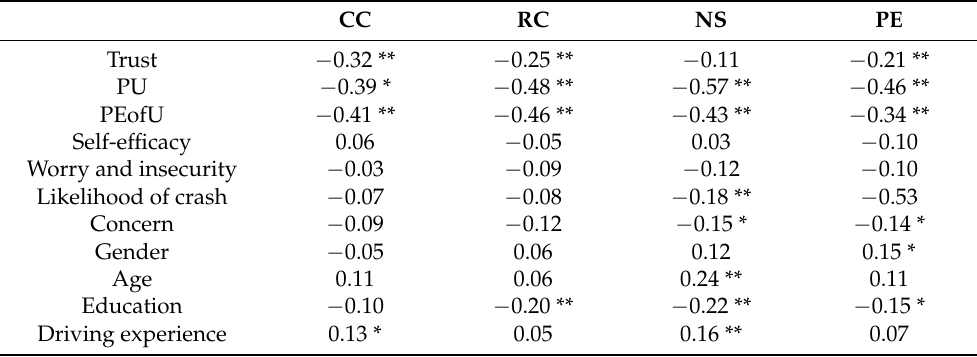
Table 9. Relationship between trust, technology acceptability, demographic factors and automated driving take-over intention.